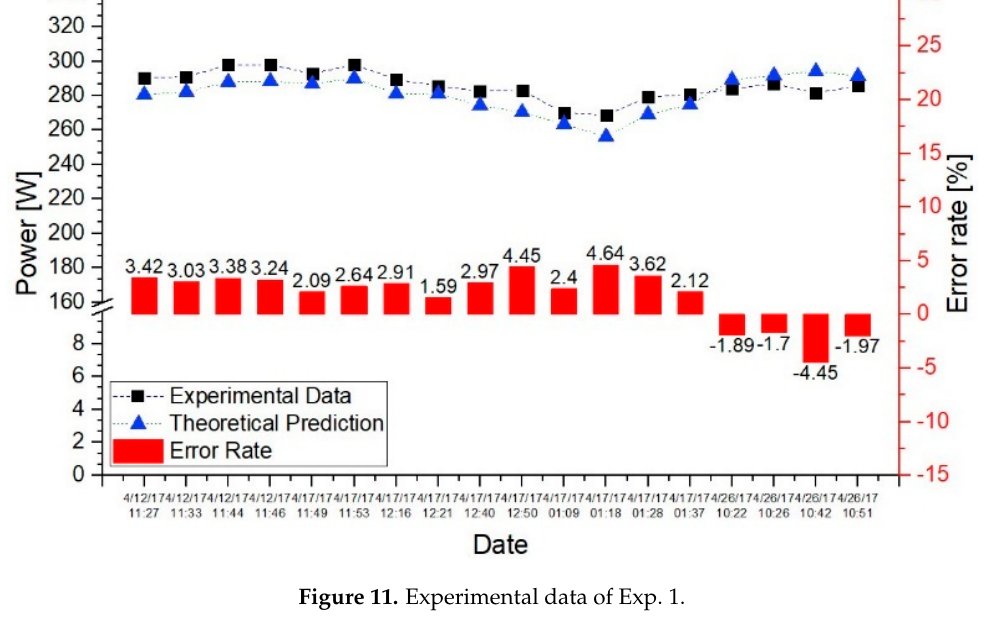
Figure 11. Experimental data of Exp. 1. Appl. Sci. 2018 , 8 , x FOR PEER REVIEW